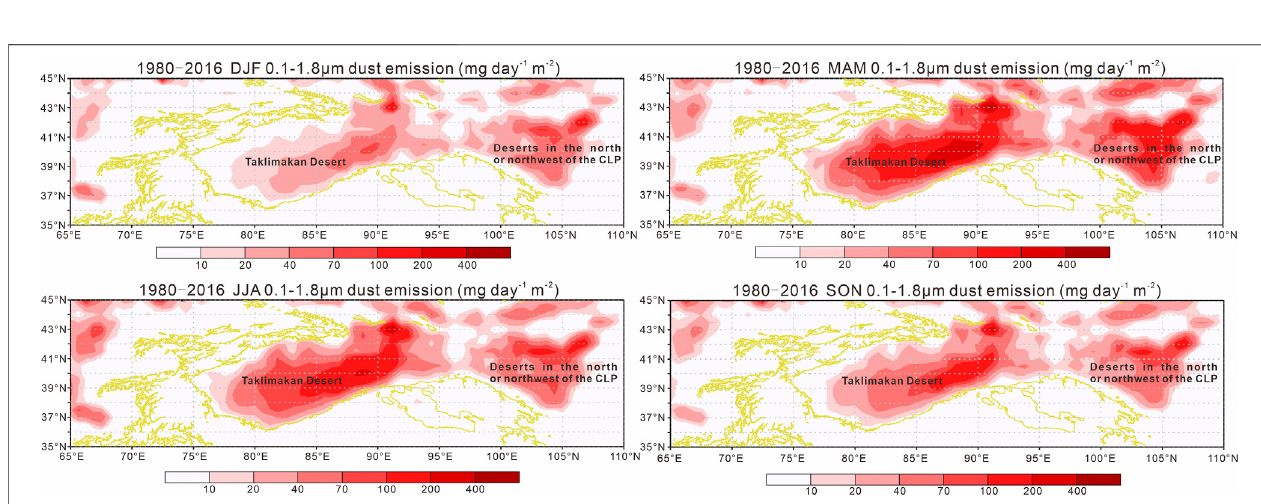
FIGURE8| DUFLUXU dust emission fl ux(kgm − 1 s − 1 )ofwinter(DJF), spring(MAM), summer(JJA), autumn(SON),and for theyear1980 – 2016.Particlesizeofthe dustis0.1 – 1.8 μ m, and thepositive/negative fl ux valuerepresentseastbound/westbound direction. Dataarecollected from MERRA2 reanalysis data(https://disc.gsfc. nasa.gov/daac-bin/FTPSubset2.pl, Gelaro et al., 2017), with spatial resolution of 0.625 ° × 0.5 ° (longitude × latitude). The yellow line represents 1,700 m isohypse line.